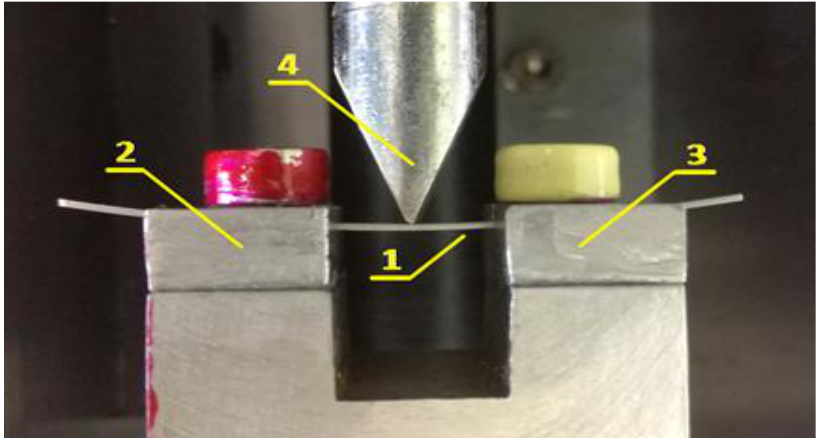
Figure 1. Three-point bending test apparatus. Position 1 indicates the sample being tested; Positions 2 and 3 indicate the specially made incisions in the props; Position 4 indicates the indenter.